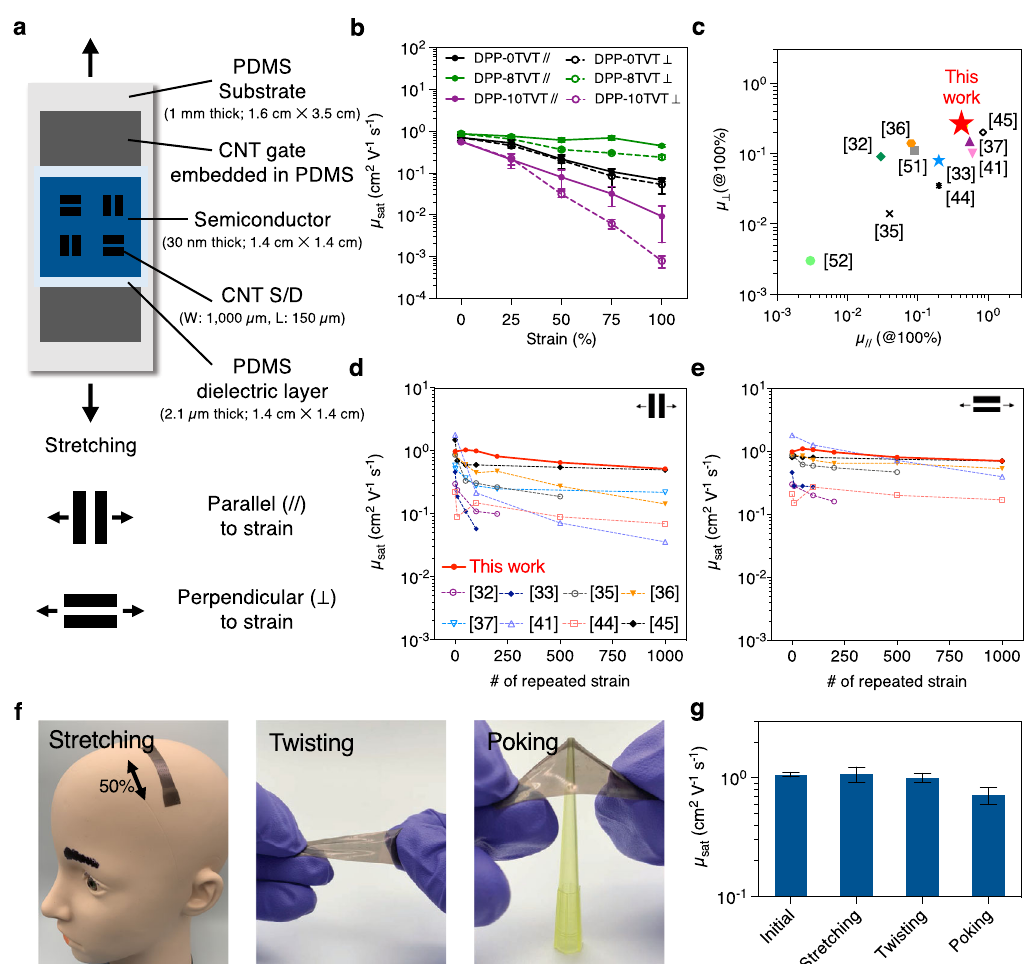
Fig. 5 Fully stretchable transistors and their applications. a Schematic structure of fully stretchable transistors fabricated with our polymer semiconductors. Carbon nanotubes (CNTs) were used for source, drain, and gate electrodes. Polydimethylsiloxane (PDMS) was used for substrates and dielectrics. b Mobility change of DPP-0TVT, 8TVT, and 10TVT under strain. DPP-8TVT showed signi fi cantly greater mobility retention under strain. Error bars represent SD. c Mobility of DPP-8TVT under 100% strain compared with those of stretchable semiconducting polymers measured in stretchable transistors reported in the literature. Mobility of DPP-8TVT after repeated strain compared with the same value of stretchable semiconducting polymers measured in stretchable transistors reported in the literature in the direction d parallel and e perpendicular to strain. f Photos of the fully stretchable transistors under various mechanical deformations. g Mobility of the fully stretchable transistors after the mechanical deformations. Error bars represent